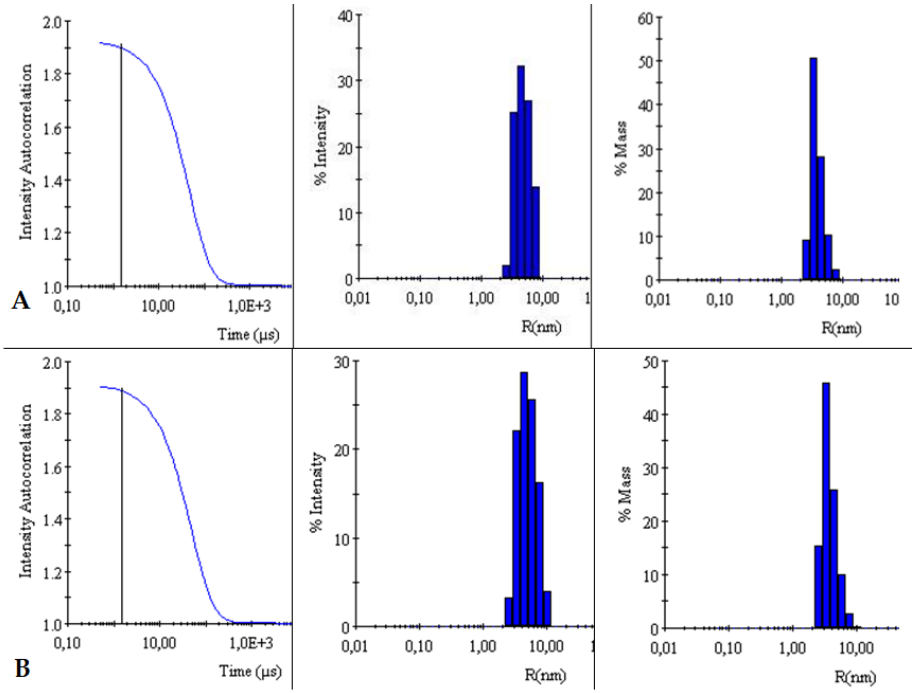
Figure 6. Comparison of intensity autocorrelation curves, % of intensity, and % of the mass of: ( A ): BSA and ( B ): BSA-TY.